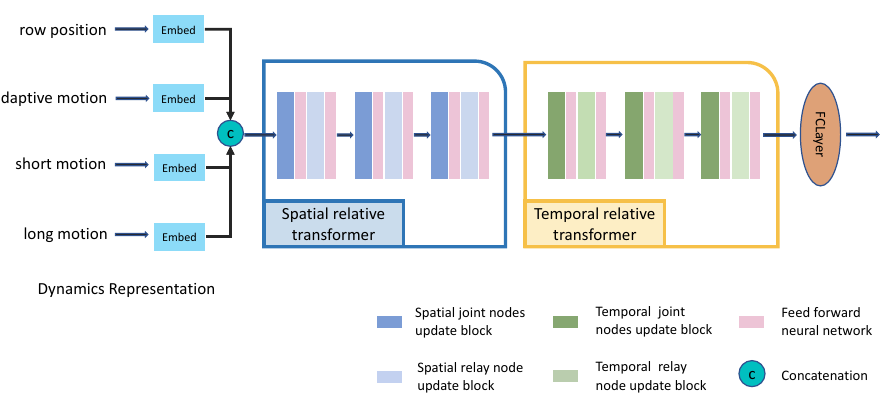
Figure 2. Illustration of the spatial-temporal relative transformer (SR-RT). The skeleton data are processed by three modules and then fed into the fully connected layer to predict the score for each action class.